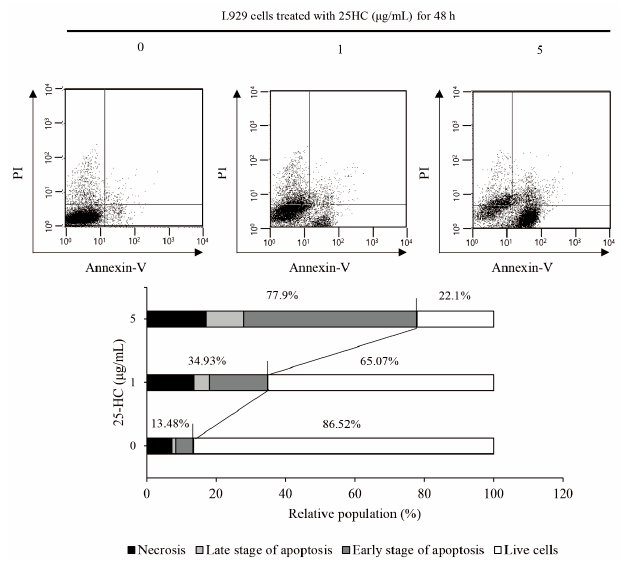
Figure 4. 25-HC increased the apoptotic population of L929 cells in a dose-dependent manner. L929 cells were treated with 1 and 5 μ g/mL 25-HC for 48 h. Thereafter, FACS using PI and Annexin V was performed to analyze the apoptotic population.